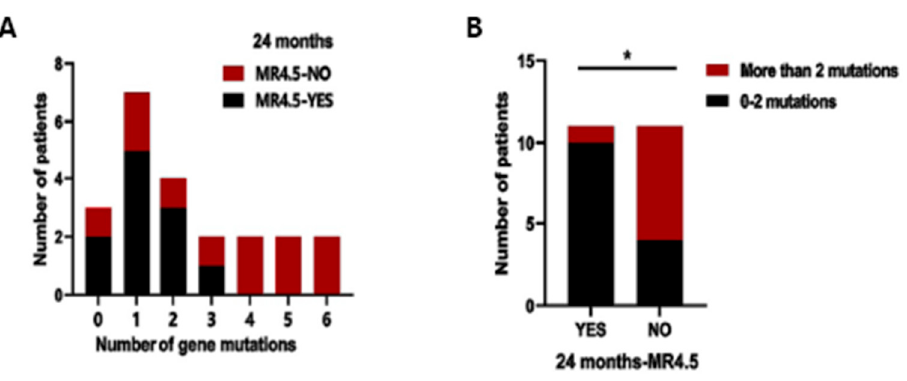
Figure 3. Proportion of mutations based on number of mutations. ( A ) Analysis of the average number of mutations based on gene function classification; ( B ) Proportion of mutations in the 24M-MR 4.5 group and the non-24M-MR 4.5 group based on the number of mutations. * p -value < 0.05.